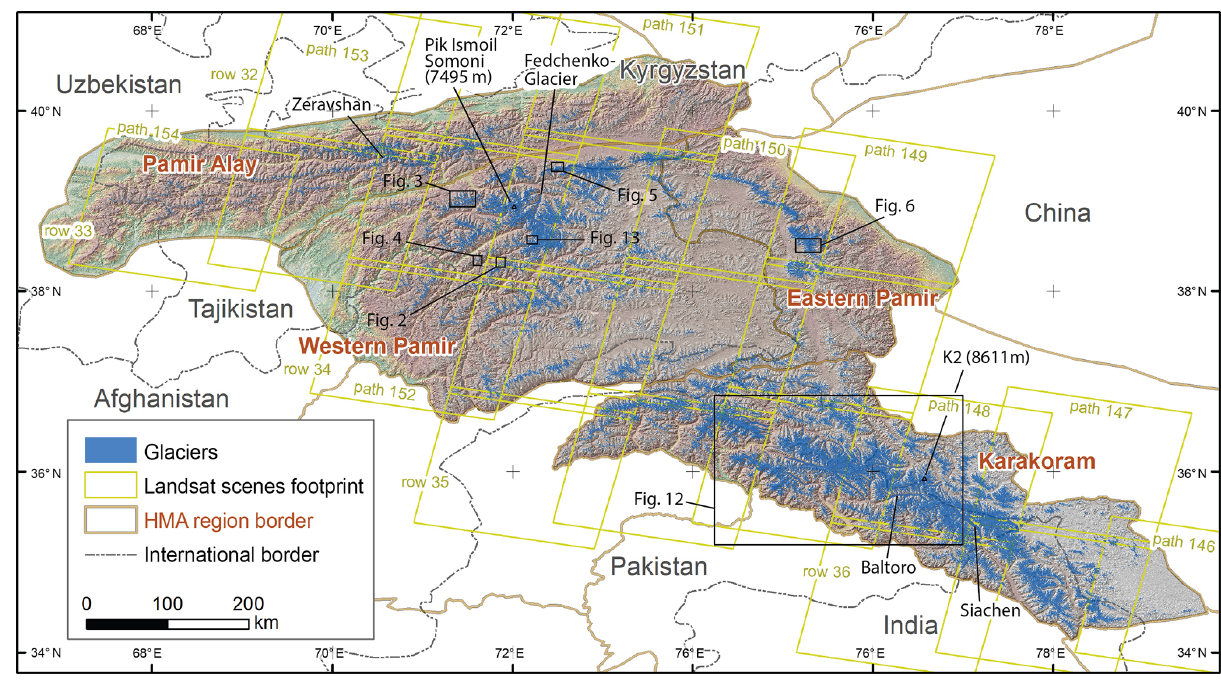
Figure 1. The study region in High Mountain Asia (HMA) covers four mountain ranges. Annotations denote locations of figures in the paper and points of orientation. International borders are tentative only as they are disputed in several